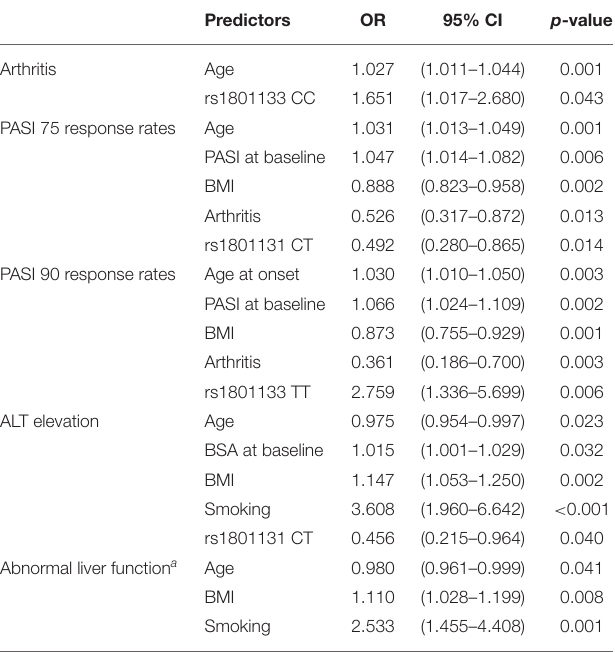
TABLE 3 | Stepwise multivariate logistic regression analysis of factors associated with concomitant PsA, the efficacy and hepatotoxicity of MTX.